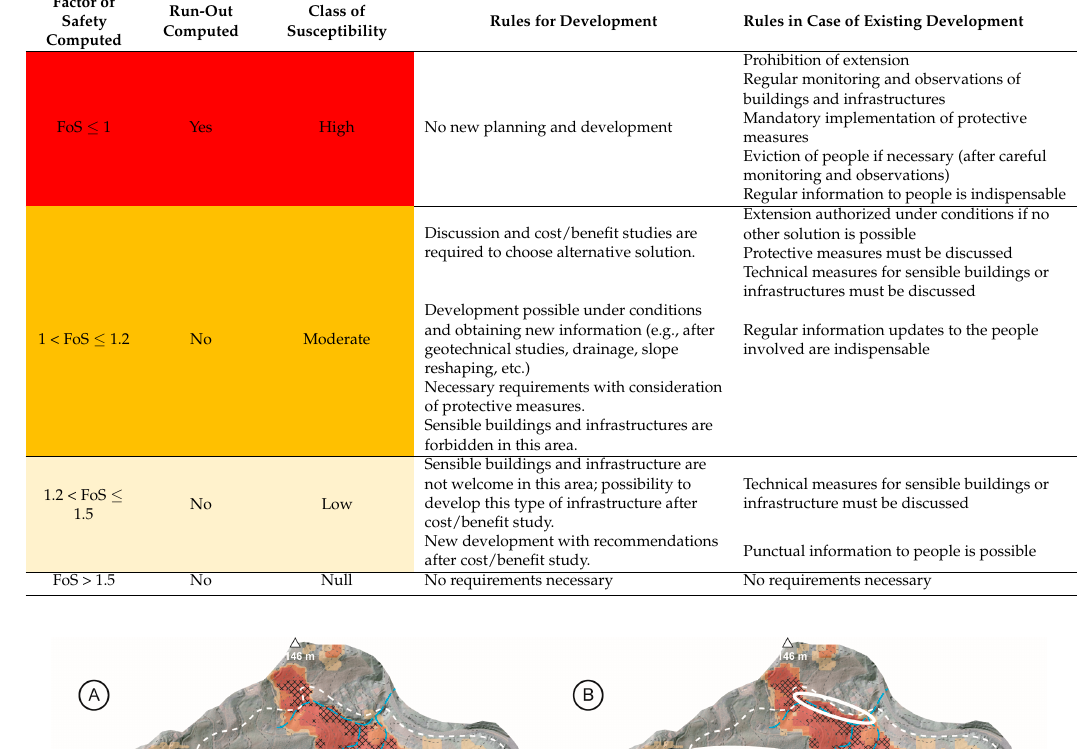
Table 5. Indications for developed and future developed areas following the new susceptibility classes. Factor of Safety